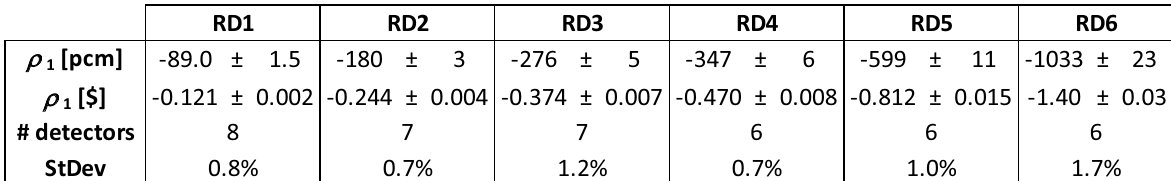
Table I. The experimental rod drop reactivity averaged over a selected set of detectors (for the rod drop location, see left part of Fig.